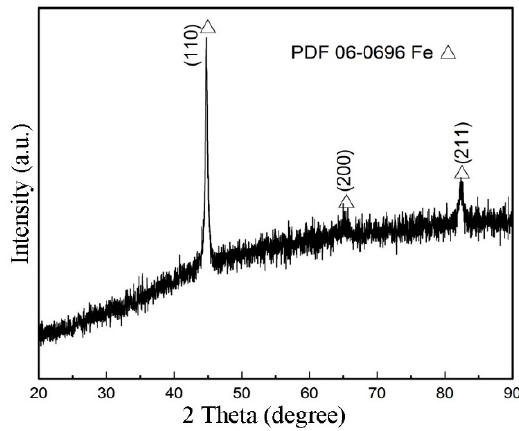
Figure 10 XRD pattern at the pin worn surface after using the RD. Figure 10. XRD pattern at the pin worn surface after using the RD.